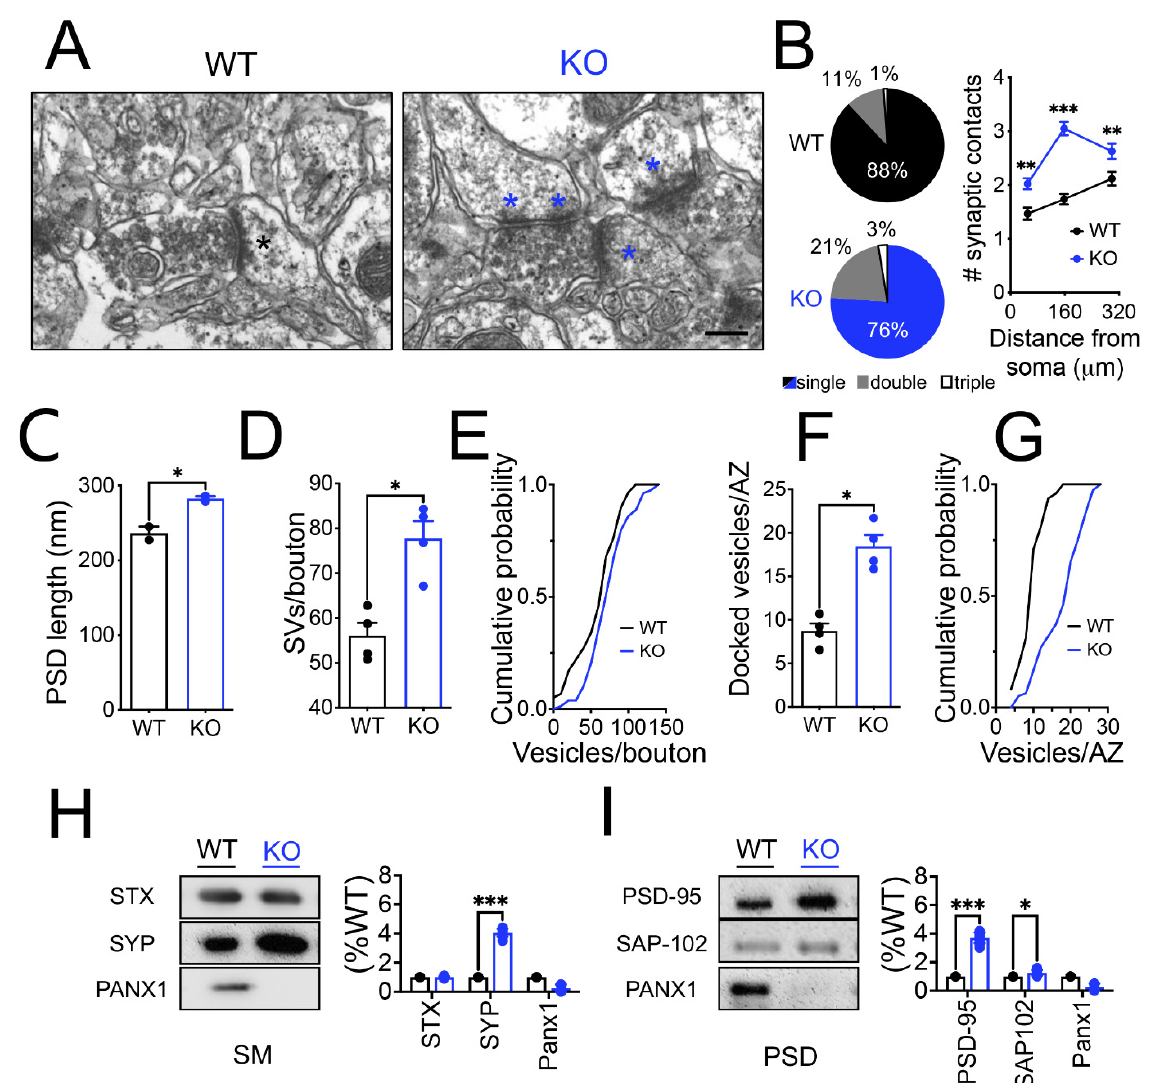
Figure 5. Multiple contacts, a higher number of docked vesicles, and enhanced PSD length in Panx1-KO synapses. ( A ) Representative transmission electron microscopy photographs of assymetric synapses of the CA1 Stratum radiatum area of WT (black) and Panx1-KO (KO, blue) mice. Magnification 43.000X, bar: 200 nm. ( B ) Percentage of single, double, and triple contacts. n = 276 (WT) and n = 392 (KO) synaptic contacts, 6 ultrathin sections from 3 animals, ** p = 0.002, *** p < 0.001 two-way ANOVA test. ( C ) PSD length. * p = 0.03 Mann–Whitney test. ( D ) Number of synaptic vesicles per bouton. n = 59 (WT) and n = 79 (KO) synaptic boutons, 6 ultrathin sections from 3 animals, * p = 0.0286 Mann–Whitney test. ( E ) Cumulative probability of the docked vesicle distribution. ( F ) Number of docked vesicles at the active zone (AZ). n = 48 (WT) and n = 78 (KO) synaptic boutons, 6 ultrathin sections from 3 animals, * p = 0.03 Mann–Whitney test. ( G ) Cumulative probability of the vesicles/AZ distribution. ( H ) Representative blots and densitometric analysis of synaptic proteins membranes avoided of PSD (SM)-enriched fractions. n = 6 (WT) and n = 6 (KO) ultrathin sections from 5–6 animals, *** p < 0.001 two-way ANOVA test. ( I ) Representative blots and densitometric analysis of synaptic protein levels in synaptic and PSD-enriched. n = 6 (WT) and n =